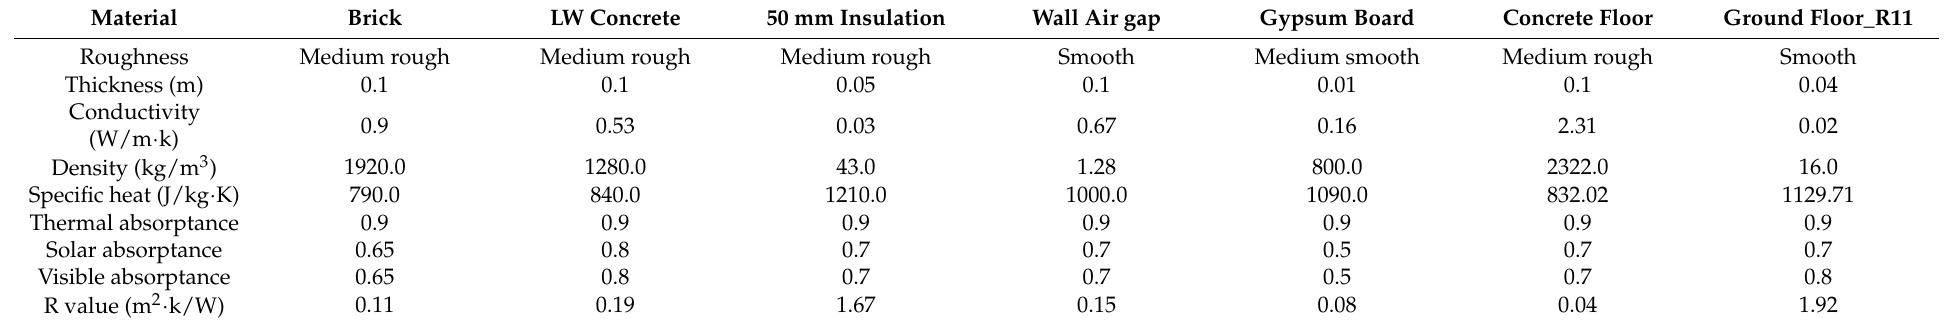
Table 2. Main construction material values.